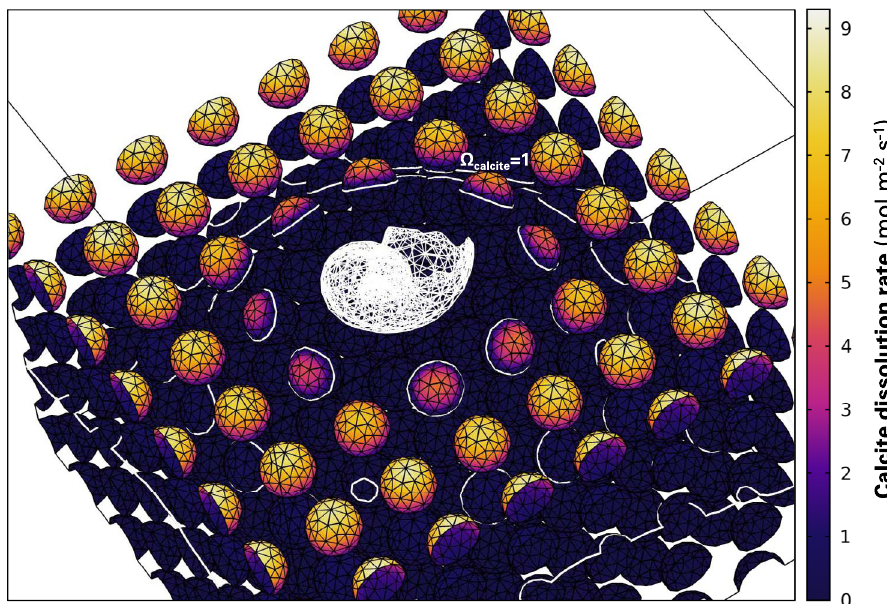
Fig. 3 Dissolution of calcite grains in a sediment bed capped with a dissolving aragonite pteropod. The pteropod is shown in a white mesh. Color gradients indicate surface calcite dissolution rates. The white lining represents a saturation state with respect to calcite of unity, i.e., a transition from undersaturation to supersaturation with respect to calcite that is caused by the dissolving aragonite